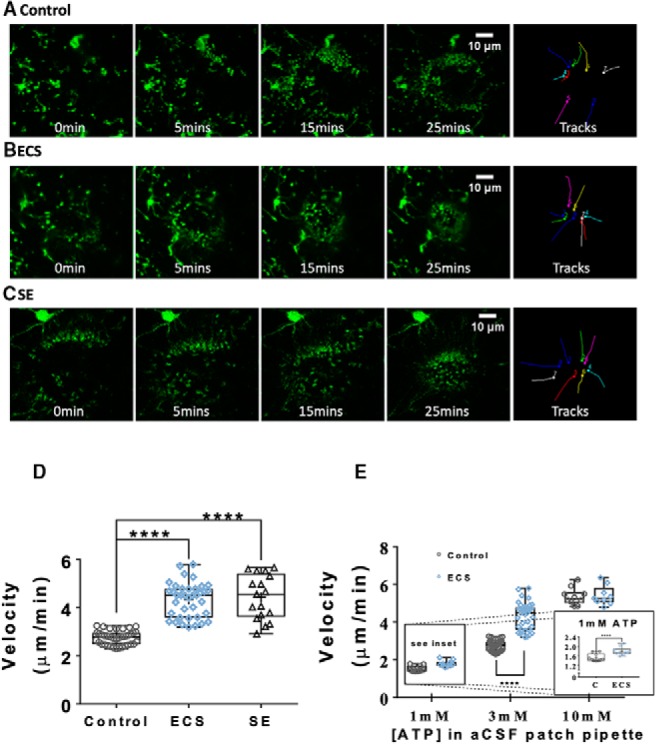
ECS, like SE, potentiated the ATP-responsive motility of microglial processes in acute hippocampal slices. A, B, Representative MIPs of confocal zt-stacks showing the time course of the microglial response (in green) to 3 mM ATP in a patch pipette (in red) in acute hippocampal slices from control (A), ECS (B), and SE (C) animals. D, ECS and SE similarly increased the average process velocity during the microglial response to 3 mM ATP. E, ECS-induced enhancement of microglial responsive motility is concentration dependent: there was a small but significant difference in the responses to 1 mM ATP, while the responses to 10 mM were not significantly different. ****p < 0.0001.